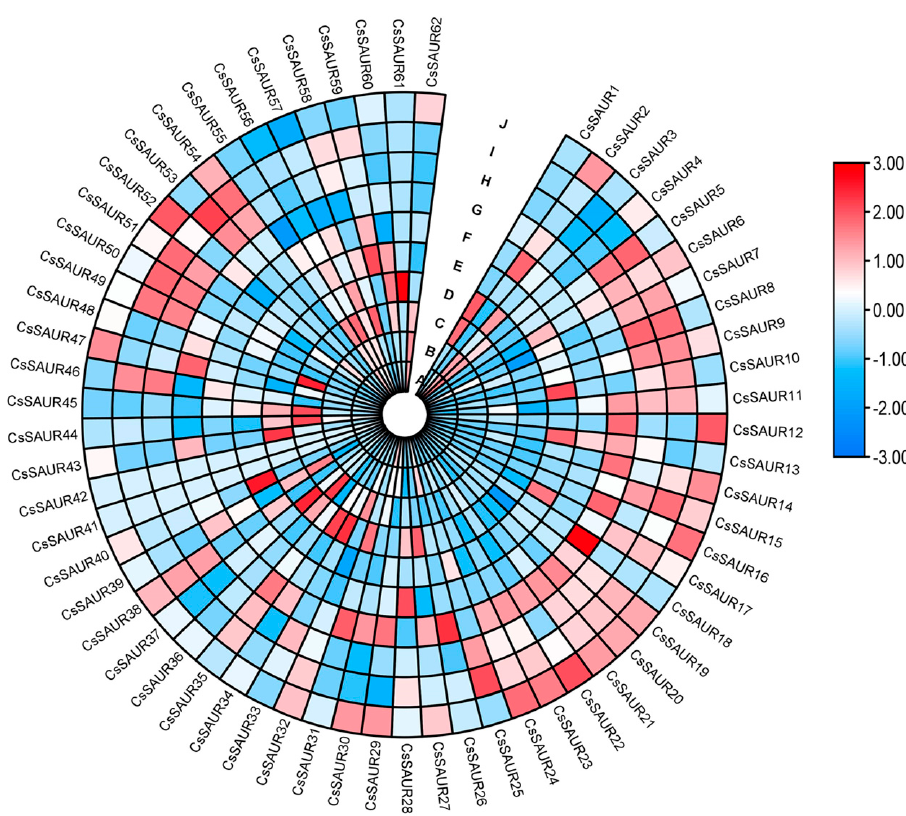
Figure 5. Heatmap highlighting the expression of different CsSAUR genes. CsSAUR genes in different cucumber organs: ( A ) ovary; ( B ) ovary (fertilized); ( C ) expanded ovary; ( D ) root; ( E ) stem; ( F ) leaf; ( G ) male flower; ( H ) tendril; ( I ) base part of tendril; ( J ) female flower tissues. The heatmap was constructed based on the FPKM. The colored bar indicates normalized gene expression in the log 2 space.